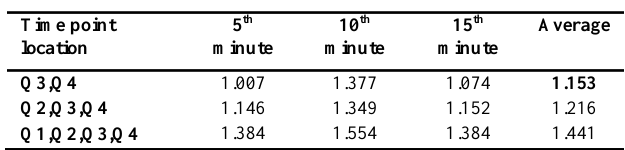
Table 1. Average value of ( ) for different numbers of points in time.